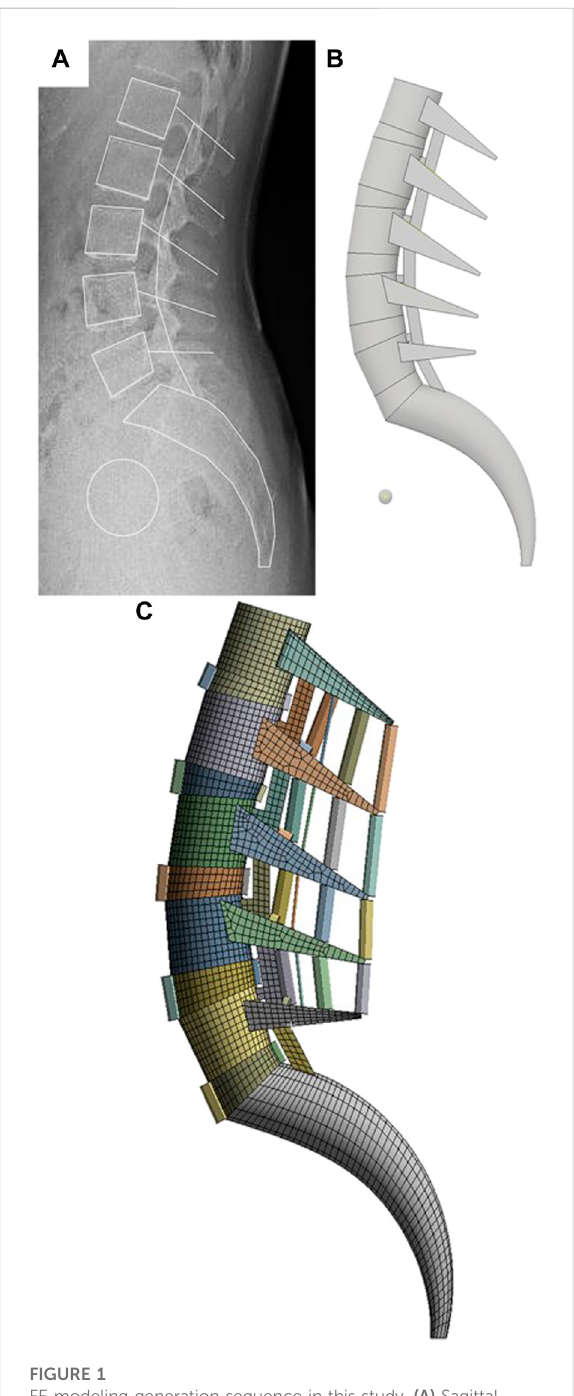
FIGURE 1 FE modeling generation sequence in this study. (A) Sagittal outline sketch of the vertebrae on the X-ray image. (B) Simpli fi ed 3D modeling based on sketch lines. (C) FE model generation using FEA